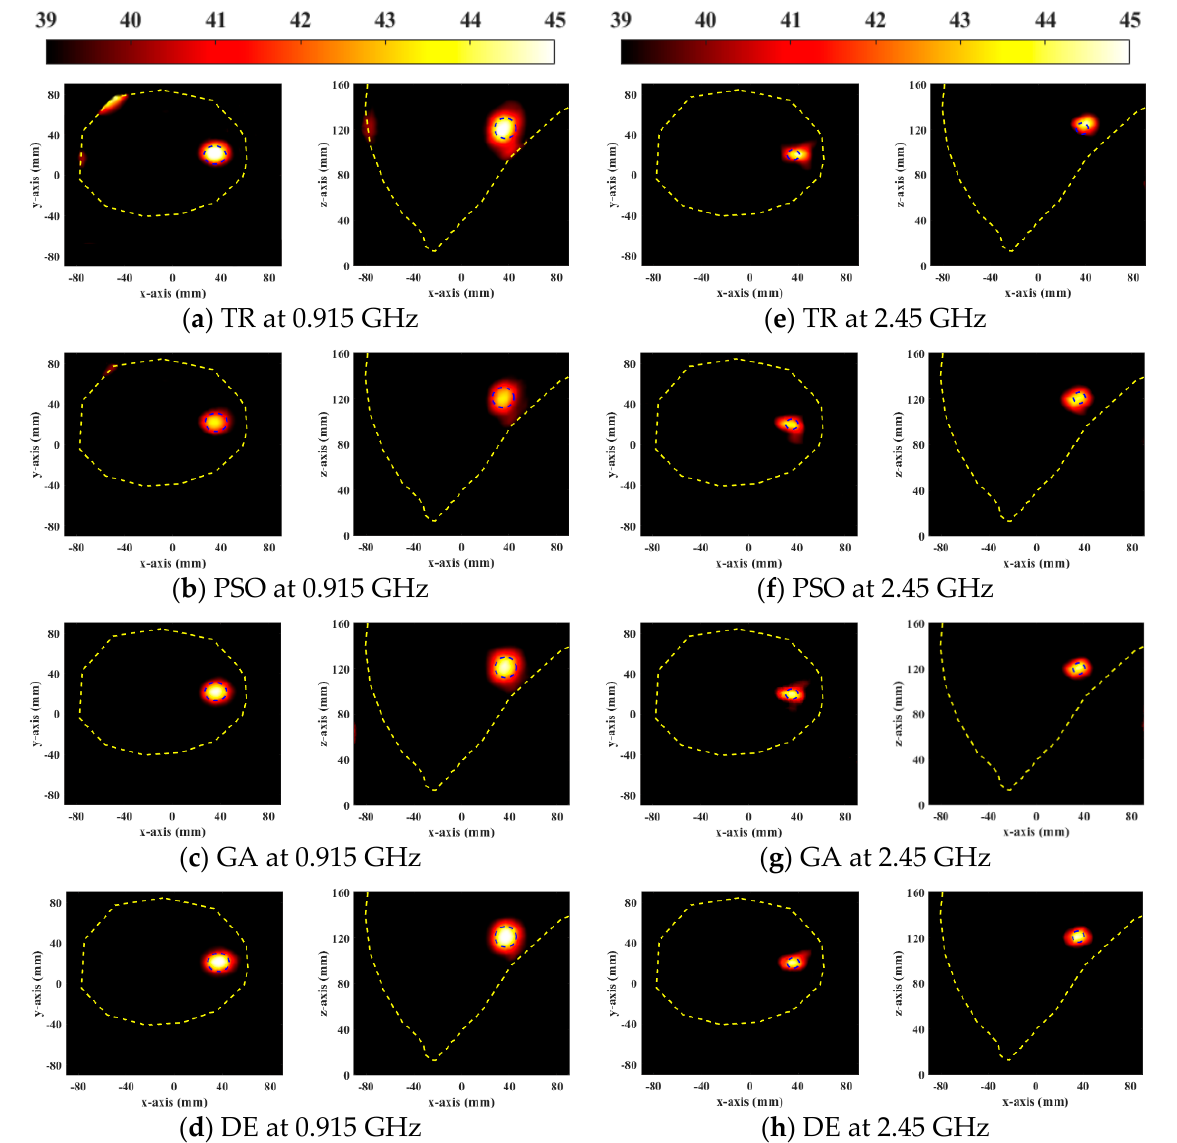
Figure 5. Steady-state temperature distribution in axial (XY) and coronal (XZ) planes of a heteroge- neous breast model treated by four FMHT optimization methods.